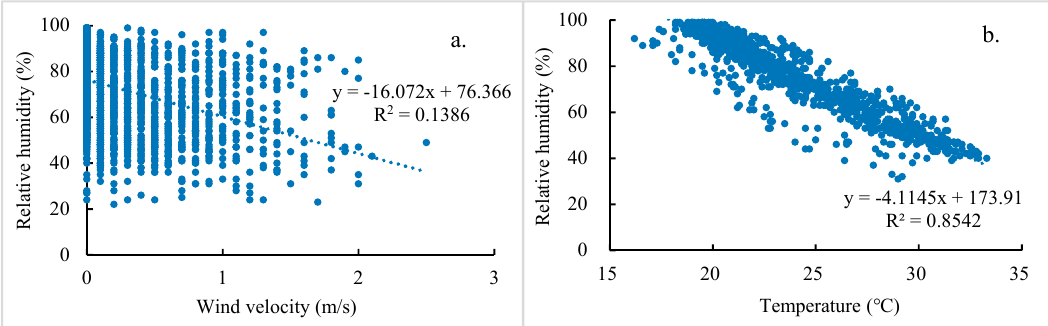
Figure 11. Correlation between wind velocity and relative humidity ( a ) and correlation between temperature and relative humidity ( b ).